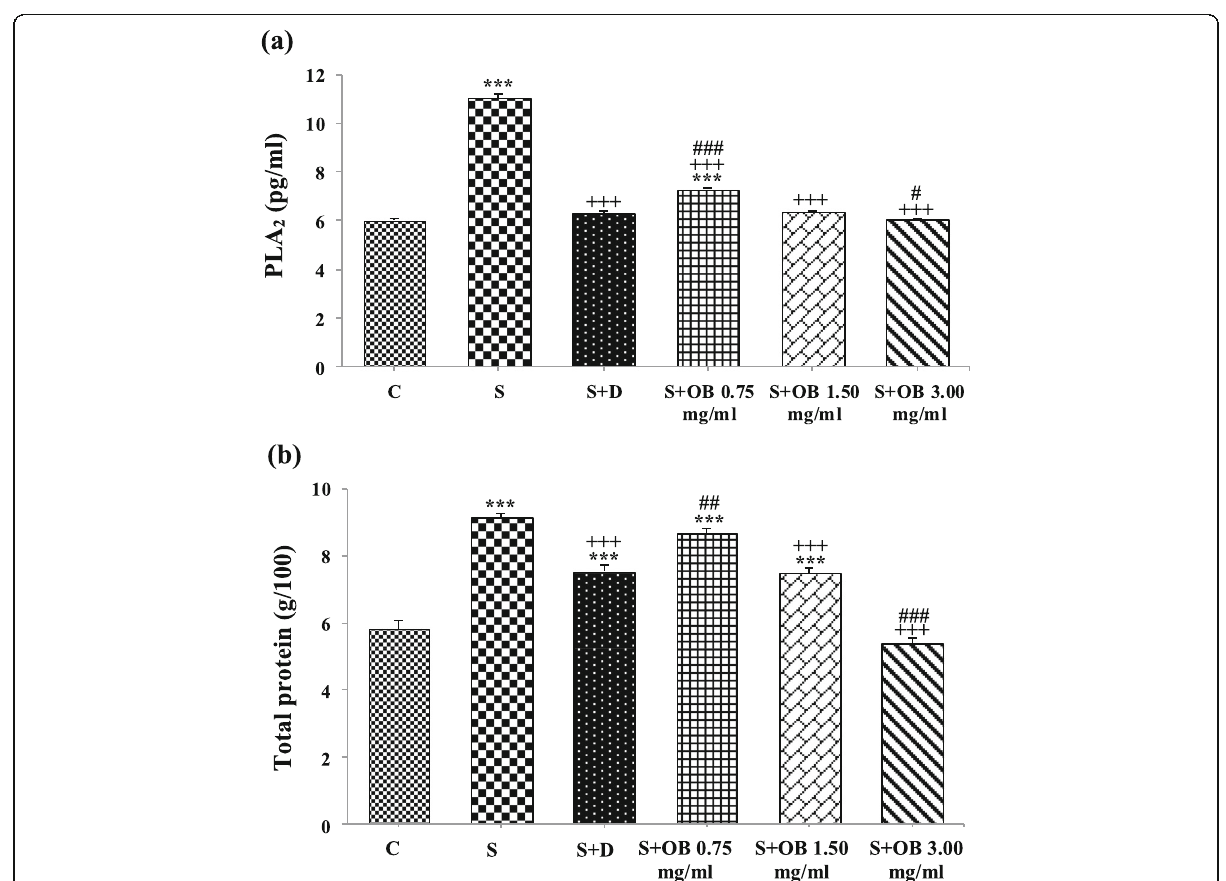
Fig. 5 Bronchoalveolar lavage fluid levels of PLA 2 ( a ) and total protein ( b ), (mean ± SEM) in the control (C), sensitized (S), treated sensitized animals with dexamethasone (S + D) and three O. basilicum concentrations (S + OB) groups, (in each group, n = 8). ***: P < 0.001, comparison with C group. +++: P < 0.001, comparison with S group. #: P < 0.05, ##: P < 0.01, ###: P < 0.001, comparison with S + D group. One-way analysis of variance (ANOVA) with Tukey-Kramer ’ s post-test was used for statistical